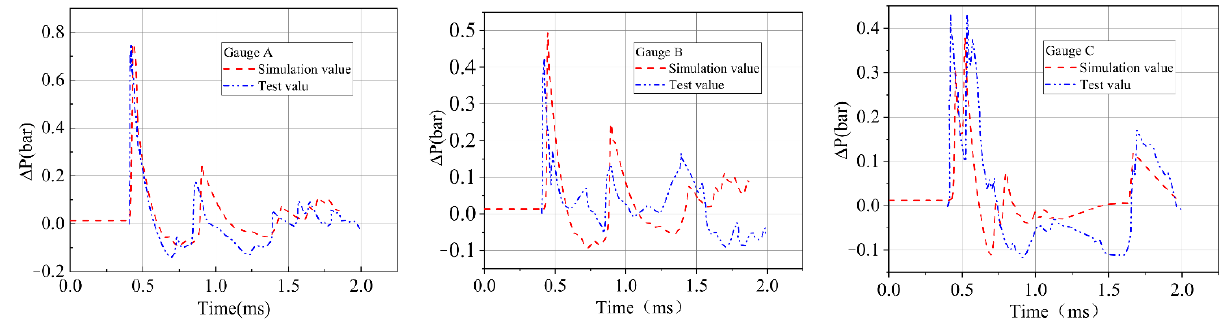
Figure 7. Comparison of numerical simulations with experimental results.